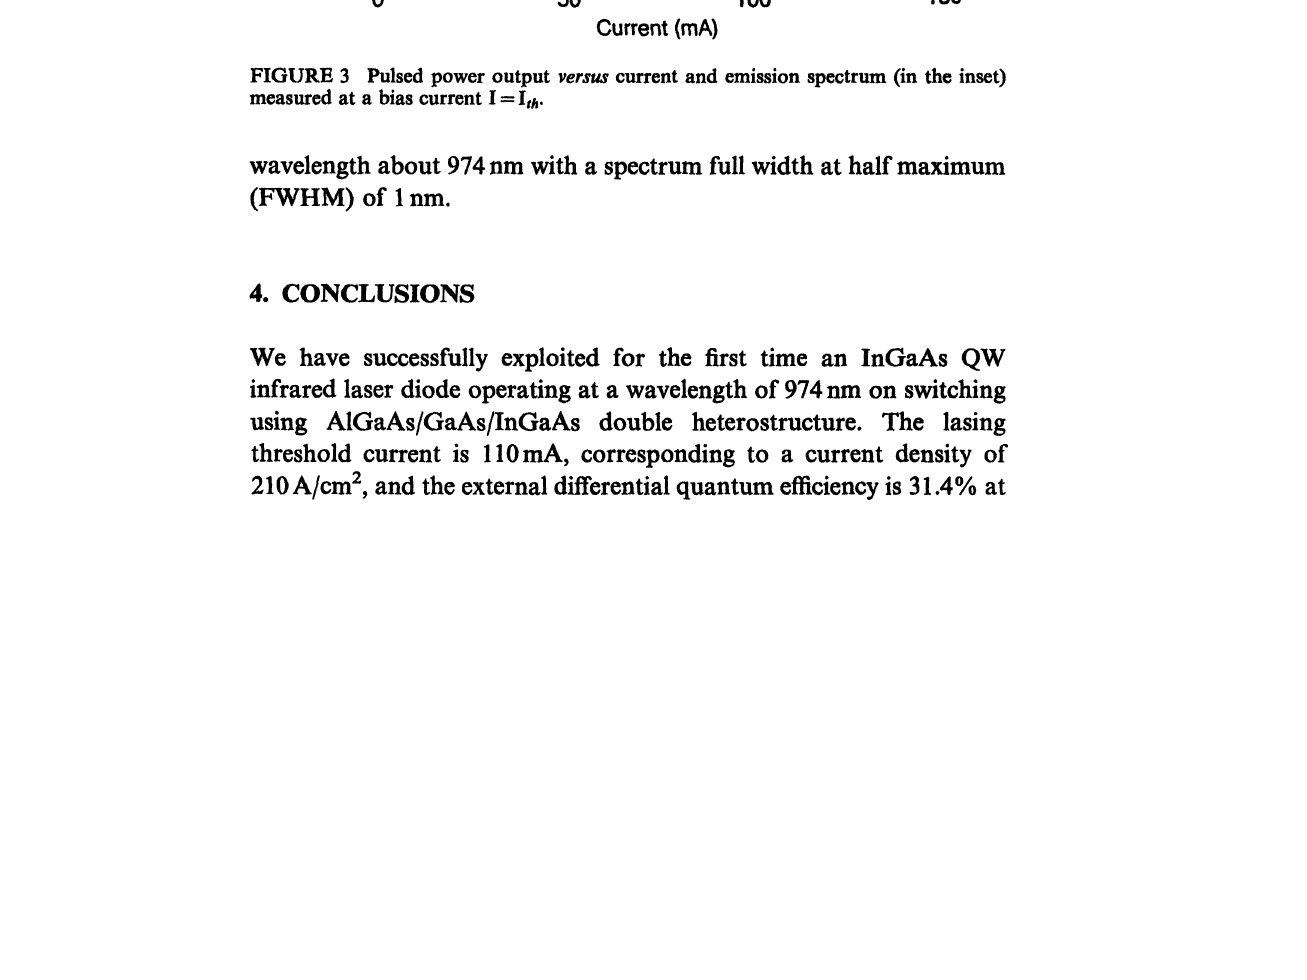
FIGURE 3 Pulsed power output versus current and emission spectrum (in the inset) measured at a bias current I